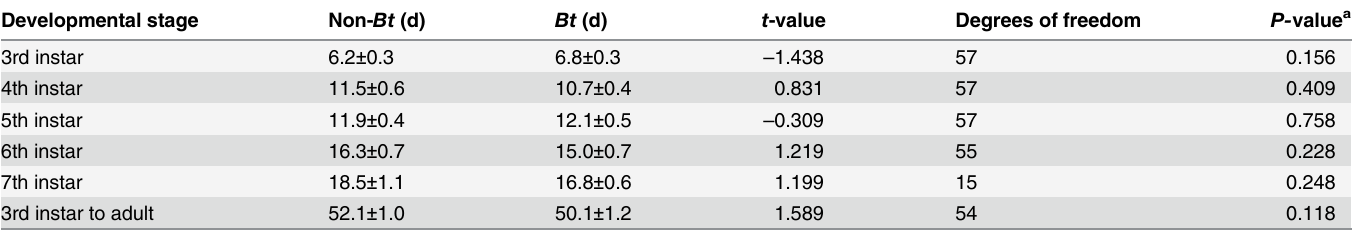
Table 2. Time (days) spent in each stage of development for P . astrigera from 3rd instar to adult emergence when exposed to either non- Bt cab- bage-fed or Bt cabbage-fed D . melanogaster . Developmental